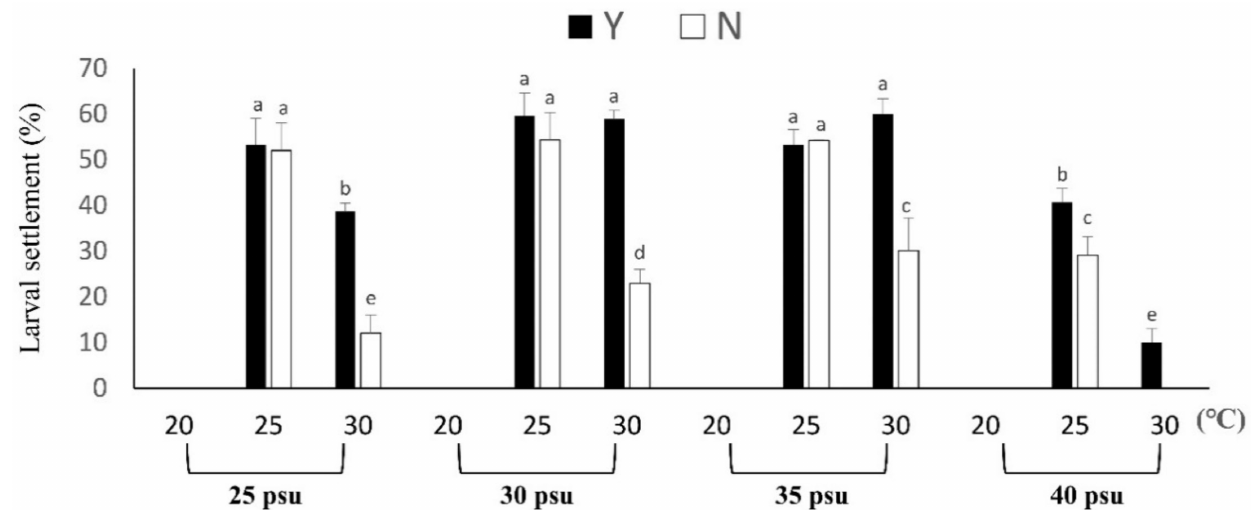
Figure 6. The effect of feeding on Briareum violacea larval settlement during temperature and salinity stress. Different Latin alphabet letters indicate significant differences among groups ( p < 0.05). The values are expressed as the means ± SDs ( n = 300 eggs). Y: feeding treatment group, N: nonfeeding treatment